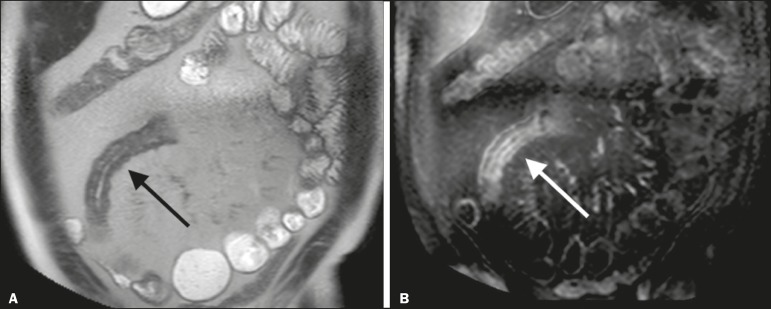
Coronal T2-weighted MRE sequence (A) and coronal, paramagnetic contrast-enhanced, fat saturated T1-weighted MRE sequence (B), showing impairment of the long segment of the distal ileum with stratification of the layers (arrows). Note also the fat proliferation adjacent to that segment, separating it from the other ileal loops.